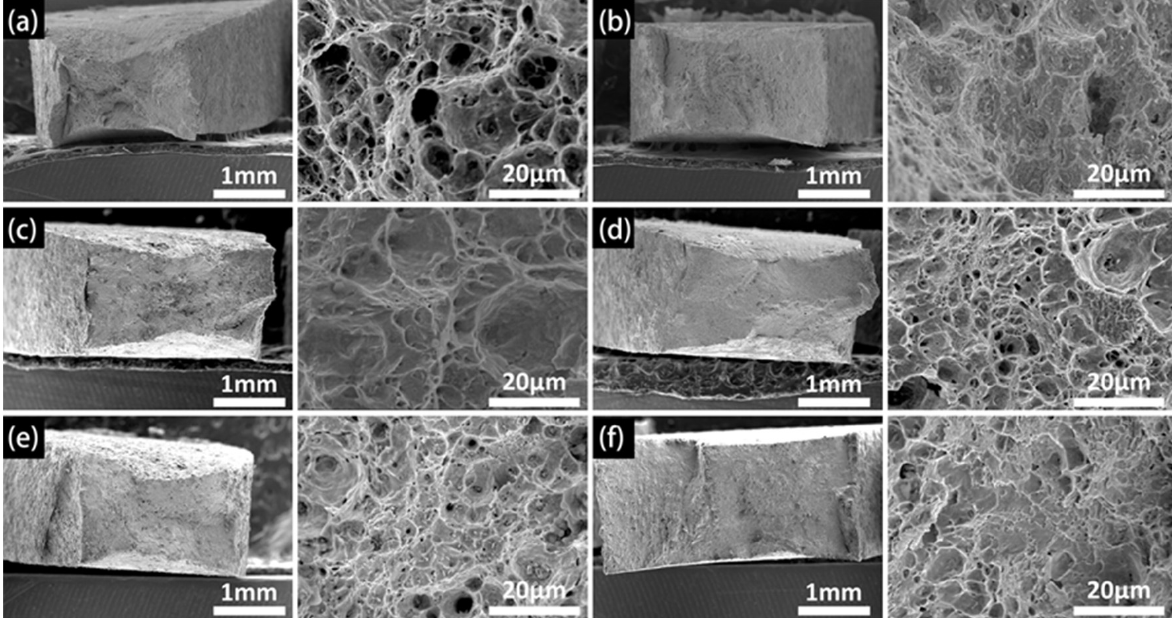
Figure 11. Fracture morphologies for X80 under different CP potentials ranging from OCP to − 1200 mV at 60 °C: ( a ) OCP, ( b ) − 800 mV, ( c ) − 900 mV, ( d ) − 1000 mV, ( e ) − 1100 mV, ( f ) − 1200 mV.